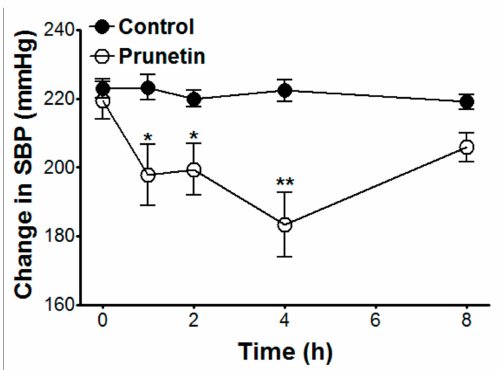
Figure 6. Hypotensive effect of prunetin on the changes in systolic blood pressure (SBP) of SHR. SBP was measured by using the non-invasive tail cuff system. The values are expressed as the mean ± SEM ( n = 6). * p < 0.05, ** p < 0.01 vs.